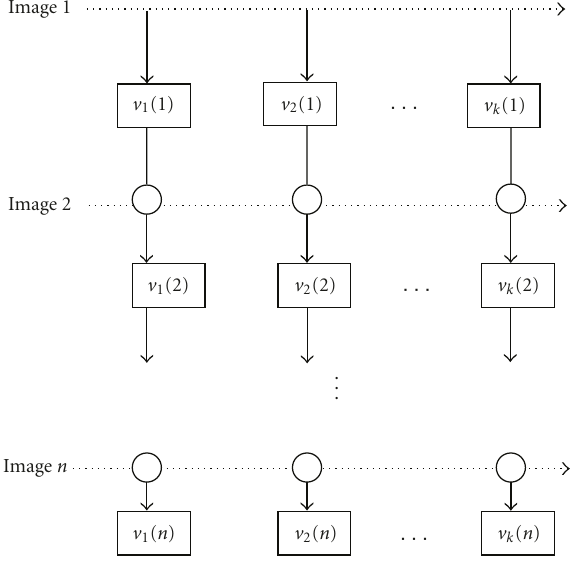
Figure 2: IPCA-PCA algorithm